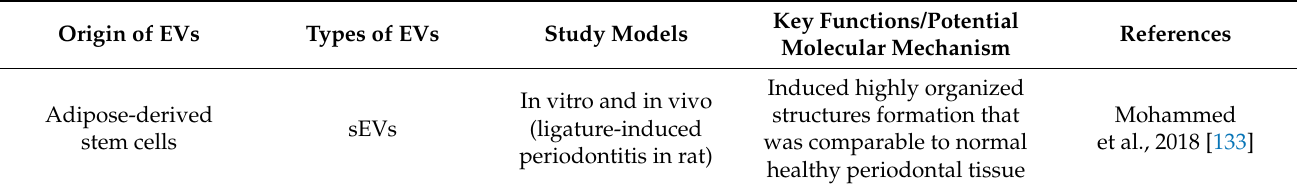
Table 2. Therapeutic effects of EVs in periodontal